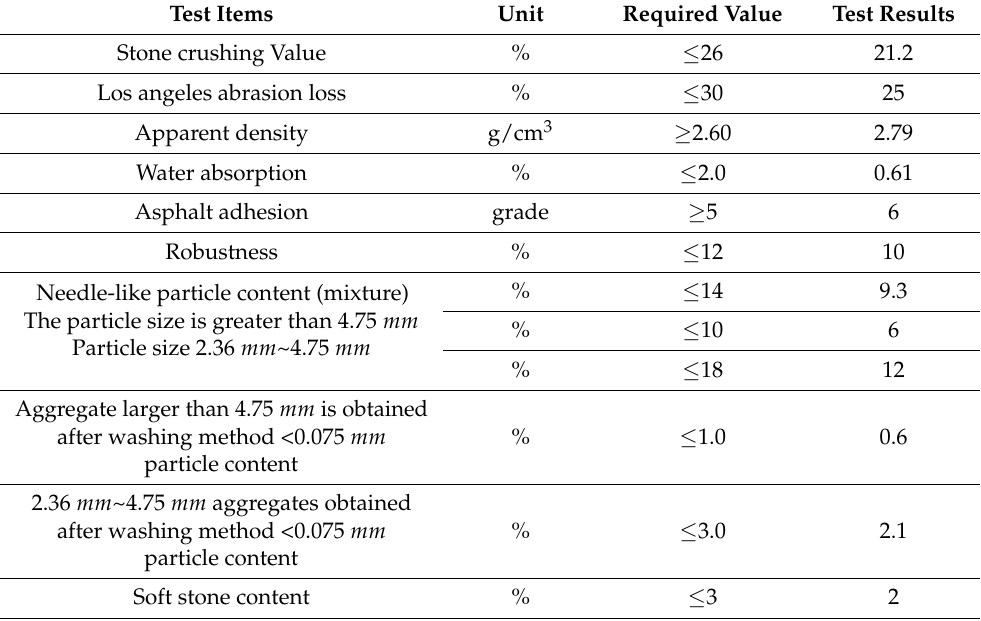
Table 1. Coarse aggregate properties and technical requirements.